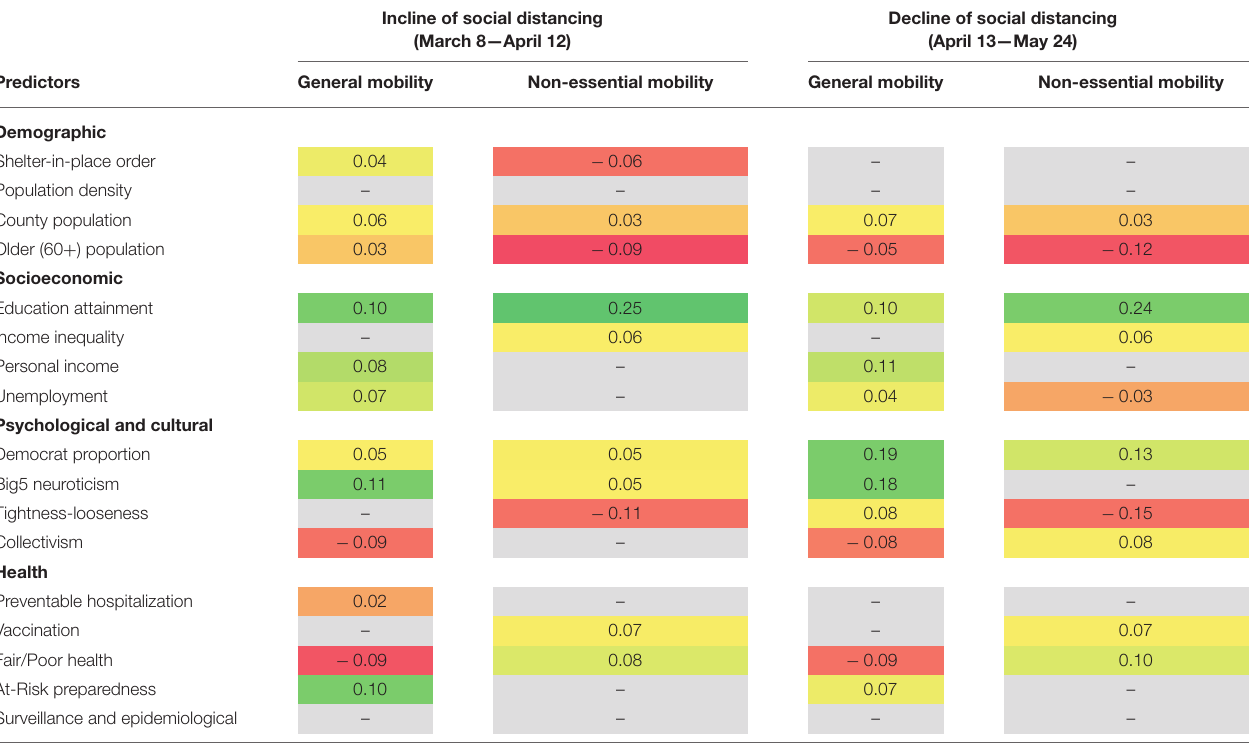
TABLE 6 | Summary of the size and direction of direct effects on social distancing